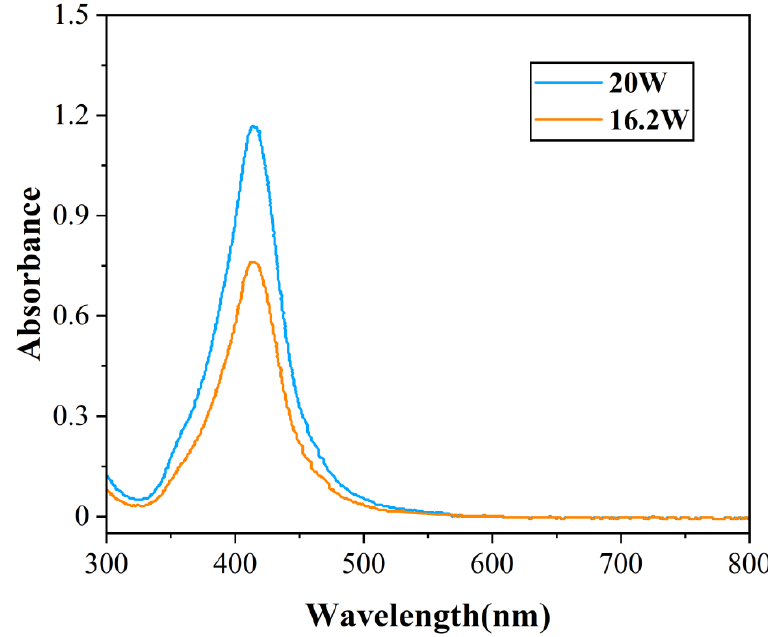
Figure 15. The absorbance of mixed nanofluids after flushing with the heating of resistance wire.